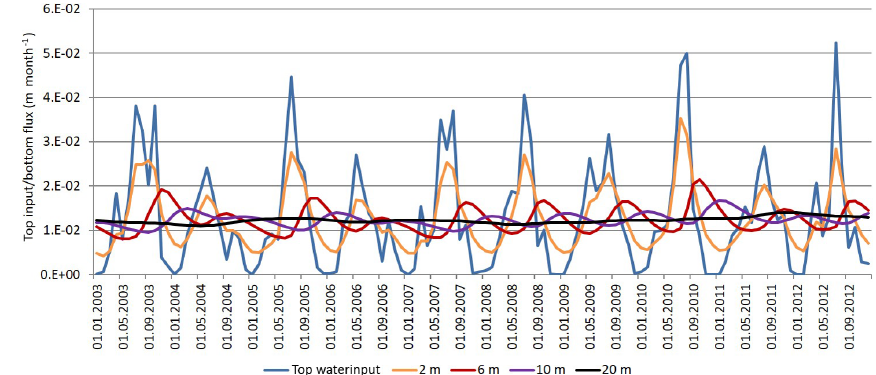
Figure 4. Calculated monthly recharge flux at different soil depths.